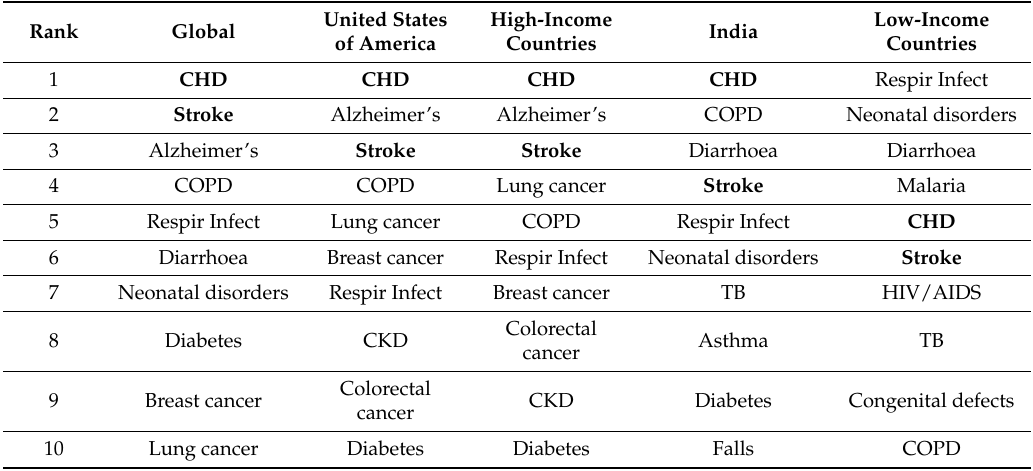
Table 1. The 10 most common causes of death in women, globally and in selected countries and regions, 2017.